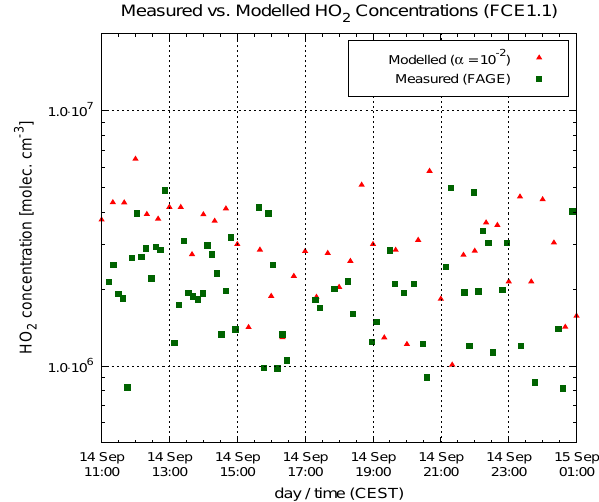
Figure 8. Comparison of the measured (green squares) and modelled (red triangles) gas-phase HO 2 concentrations at the Mt Schmücke site during cloud event FCE1.1 (14 and 15 September 2010, 11:00–01:00CEST).